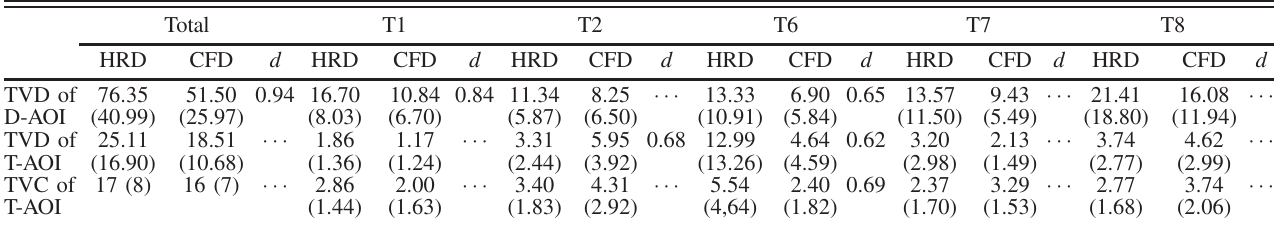
TABLE V. Comparison of the HRD and CFD item pairs in terms of total visit duration (TVD) and total visit counts (TVCs) of the D- (diagram) and T-AOIs (text). The mean value M and the standard deviation in parentheses ( SD ) are given. For significant differences, the effect size d is